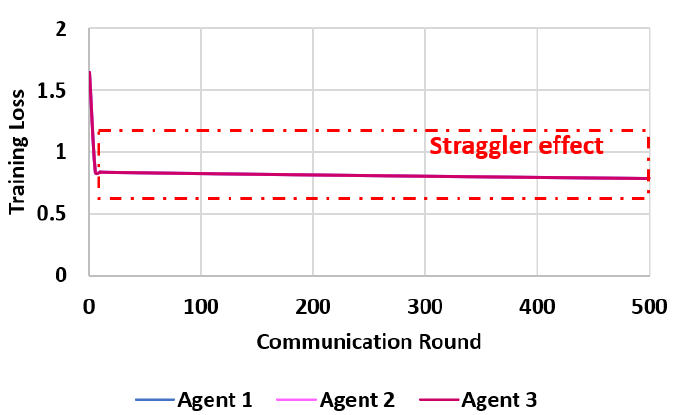
Figure 3. Straggler effects on participating FL agents’ (three agents and two stragglers) model loss for the prediction of critical infrastructure outage.